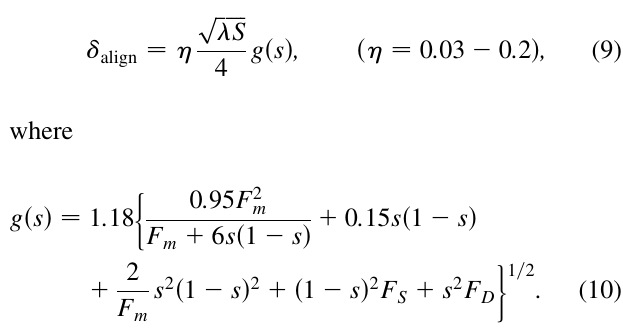
(cid:3) 0 : 35 , right m